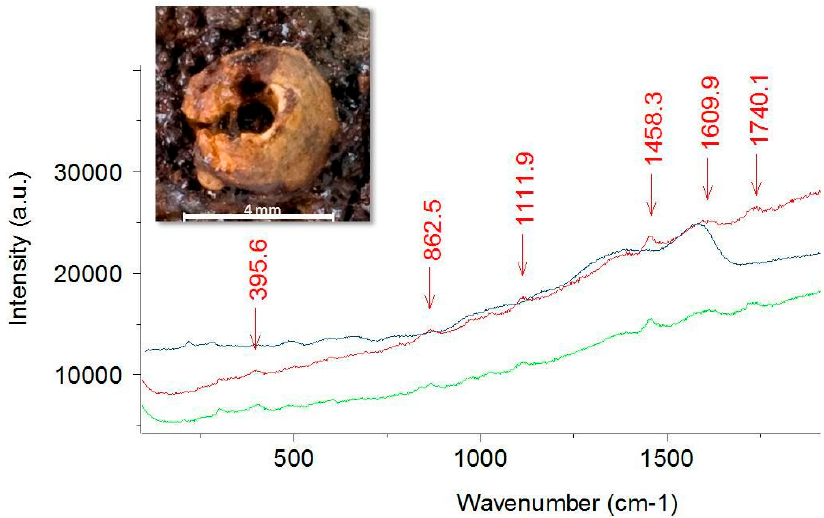
Figure 6. Ilvesheim “Weingärten”; Raman spectrum of foot bead of small iron fibula. The characteristic ν 1 and ν 2 frequencies of the pigments at 1520 and 1129 cm − 1 are still very intense. Red = pigments; black = calcite.